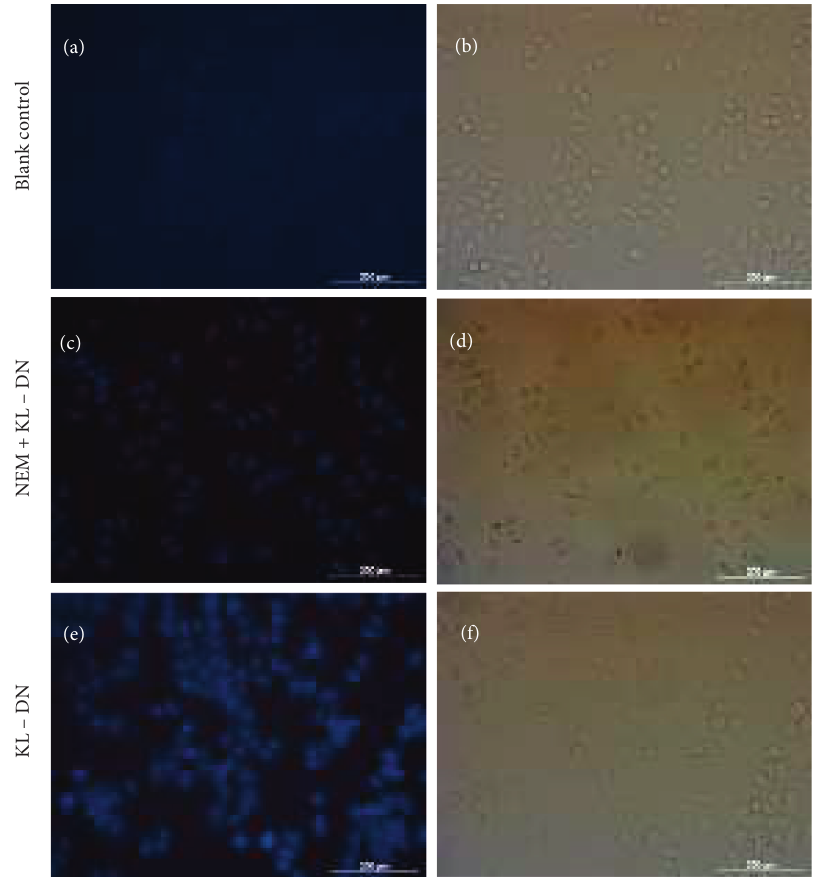
Figure 4: Microscopic images of HeLa cells. (a) Blank control. (b) Corresponding bright field image. (c) Preincubation with 5 mM NEM thiol scavenger for 1h at 37 ° C, followed by incubation with 40 μ M KL-DN for 3h at 37 ° C. (d) Corresponding bright field image. (e) Incubation for 3 h at 37 ° C with 40 μ M KL-DN . (f) Corresponding bright field image. Scale bar � 200 μ m.